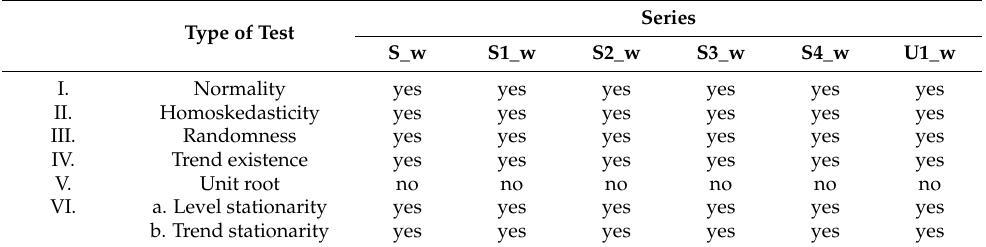
Table 13. Results of statistical tests on the weekly series.